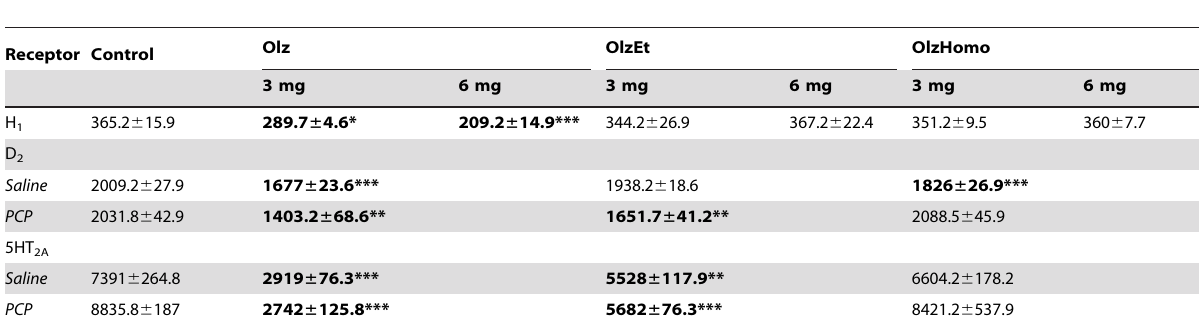
Table 2. Brain receptor densities in female rats treated with Olz and Olz derivatives.